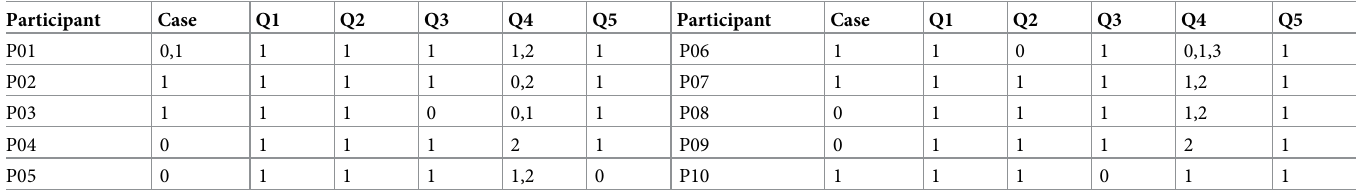
Table 3. Participants’ answers on the questionnaire. The values for ‘case’ refer to whether participants were in the experiment with longitudinal (0) or lateral (1)